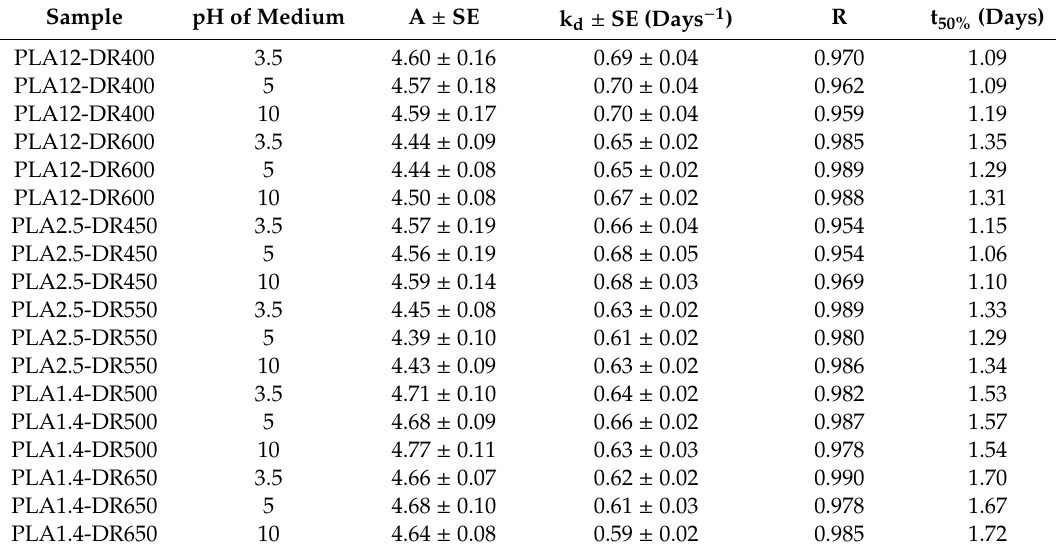
Table 3. Kinetic parameters of the intrinsic viscosity percent remaining of the studied samples during thermal-supported hydrolytic